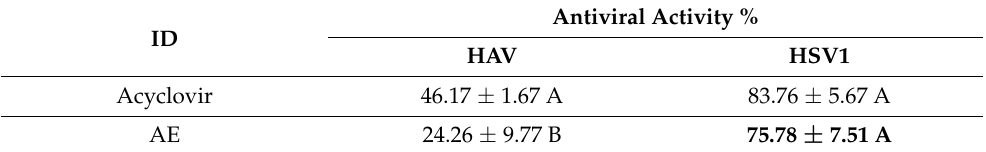
Table 4. Antiviral efficacy of the Annona glabra extract versus HAV and HSV1 vs. acyclovir (M ± SE).